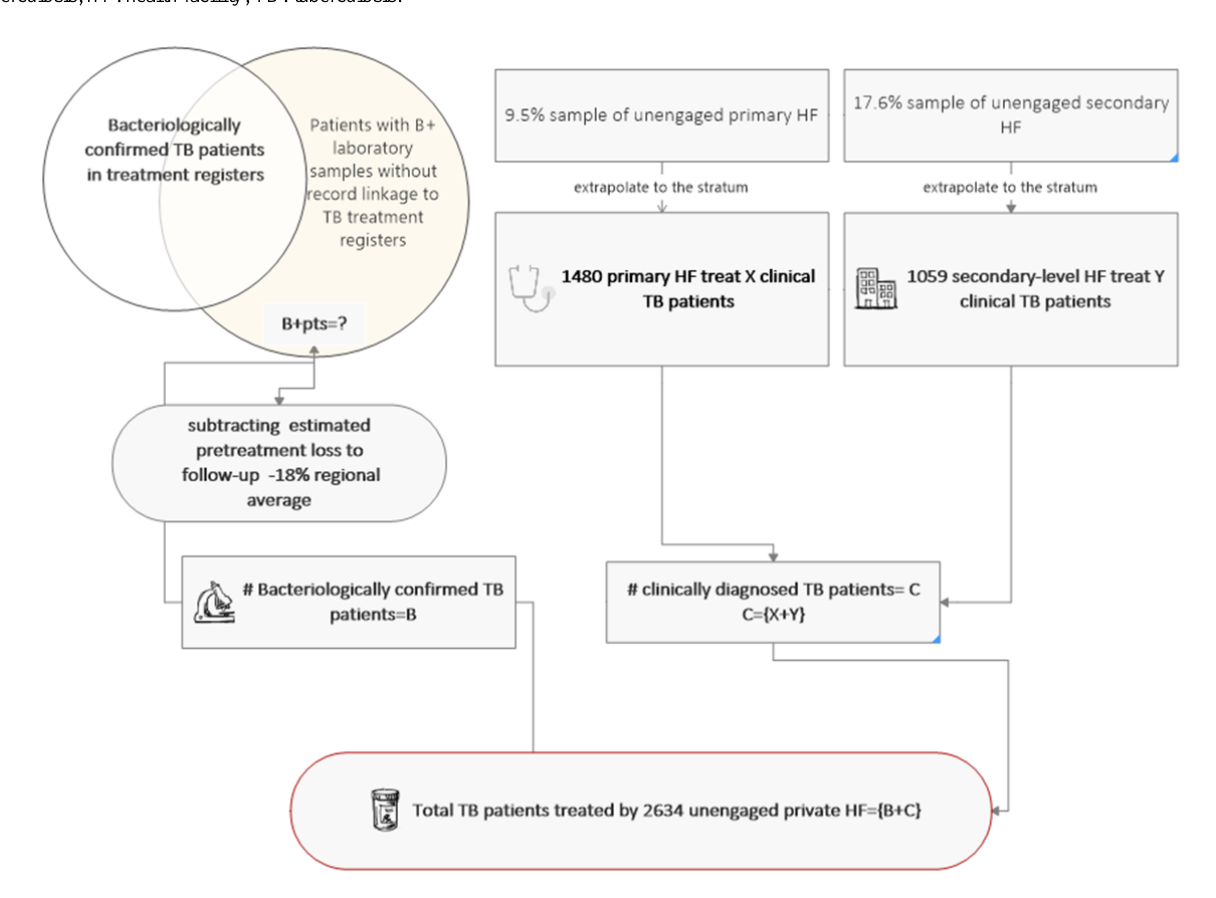
Figure 5. Process used to estimate the total number of tuberculosis cases treated in the unengaged private sector. B+: bacteriologically confirmed tuberculosis; HF: health facility; TB: tuberculosis.